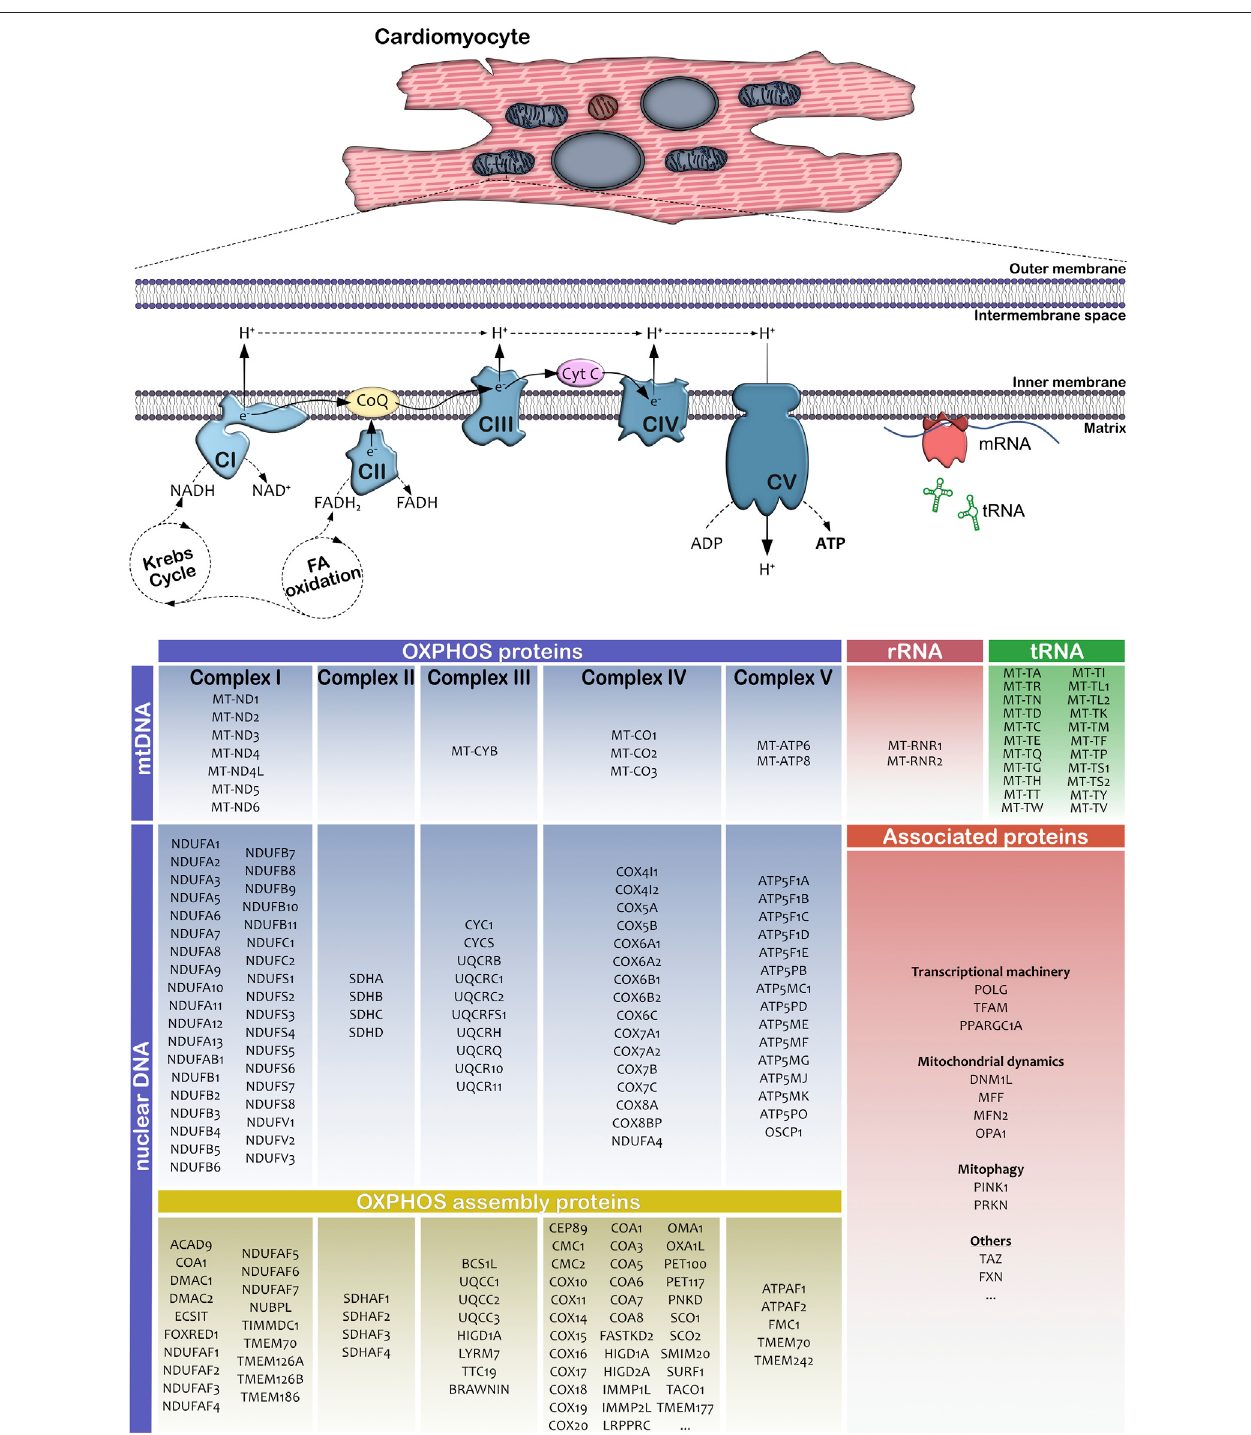
FIGURE1| Schematicrepresentationofmitochondria-associatedgenesinvolvedinproteinsynthesisandcomplexformationoftheoxidativephosphorylationand ATP synthesis. The table summarizes the most important OXPHOS subunit and assembly proteins in human cells. mtDNA indicates mitochondrial DNA; nDNA, nuclear DNA; rRNA, ribosomal RNA; tRNA, transfer RNA; FA, fatty acids; CI, Complex I or NADH ubiquinone oxidoreductase; CII, Complex II or succinate dehydrogenase; CIII, ComplexIII orubiquinol-cytochrome coxidoreductase; CIV, Complex IV or cytochrome coxidase; CV,ComplexVor ATP synthase; CoQ,coenzymeQ10and Cyt C, cytochrome